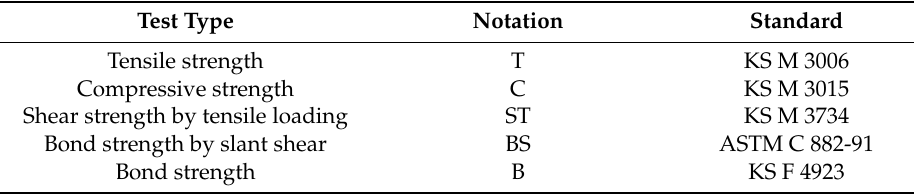
Table 3. Material properties and test